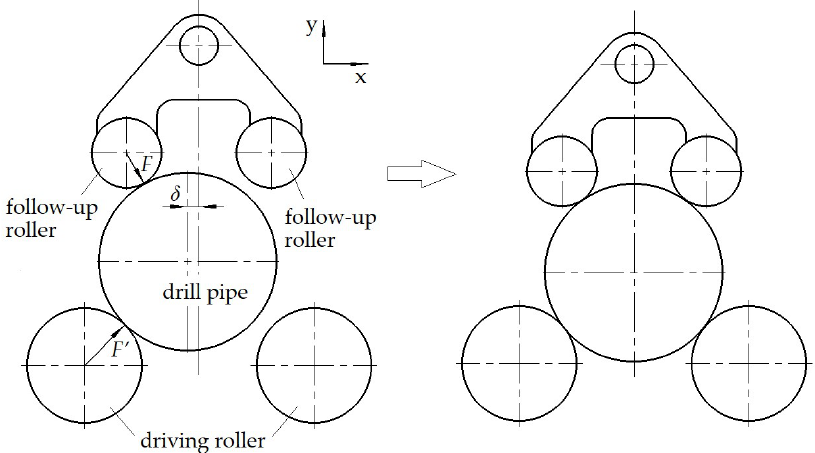
Figure 5. Schematic diagram of eccentric to tight state.